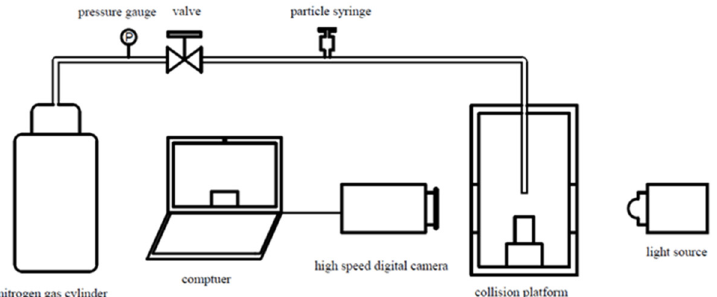
Figure 1. Schematic diagram of experimental system in which coal ash particles impact with flat plate surface.